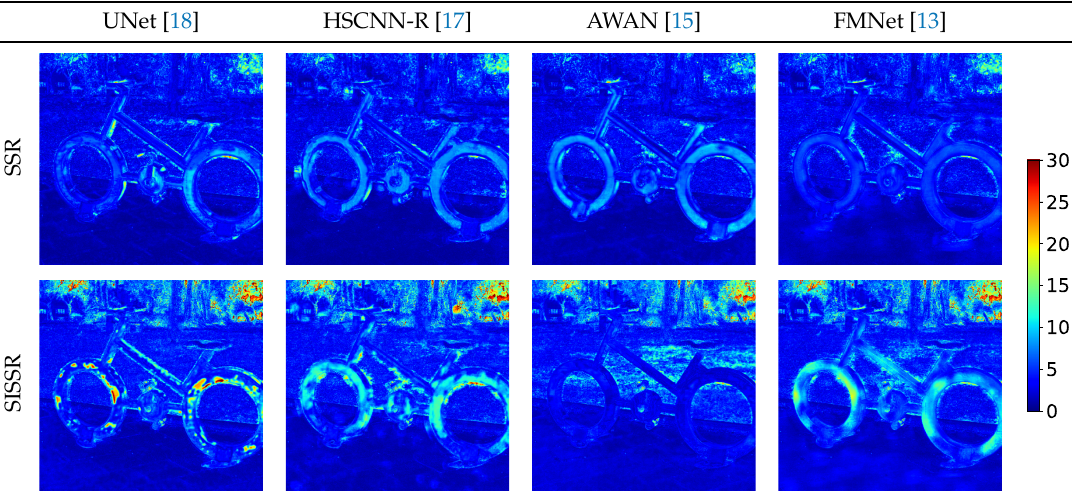
Figure 4. An exemplary image from the dataset NTIRE 2020 [11].